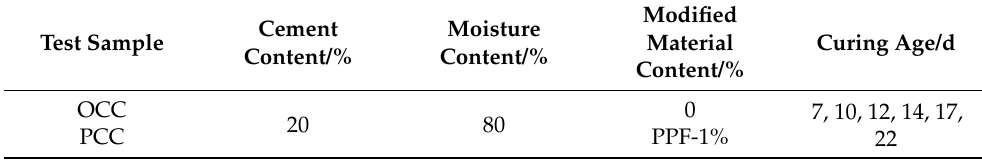
Table 3. UCS test scheme for OCC and PCC under room temperature curing .